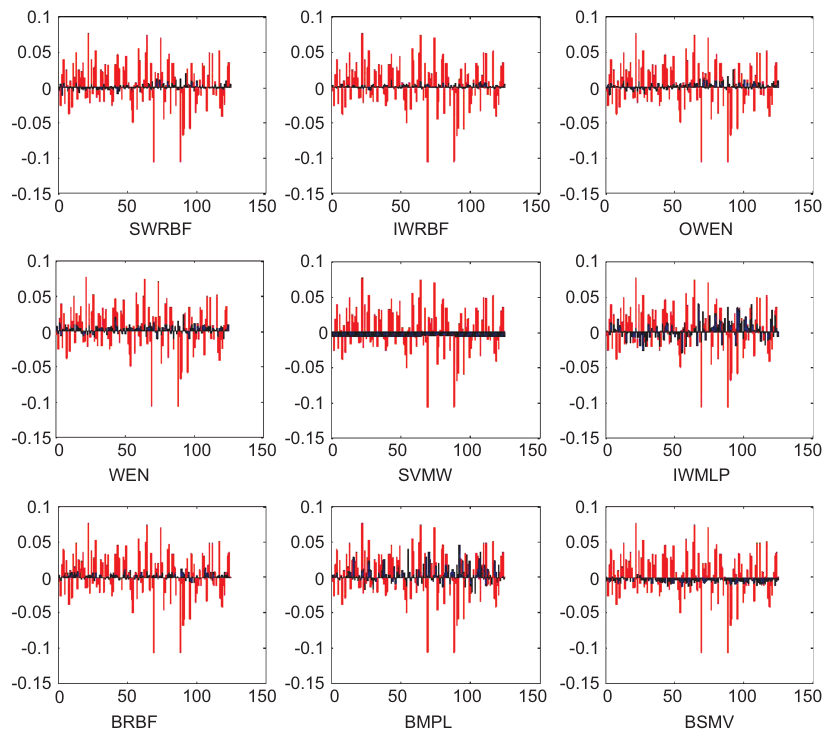
Figure 3. Volatility Forecast